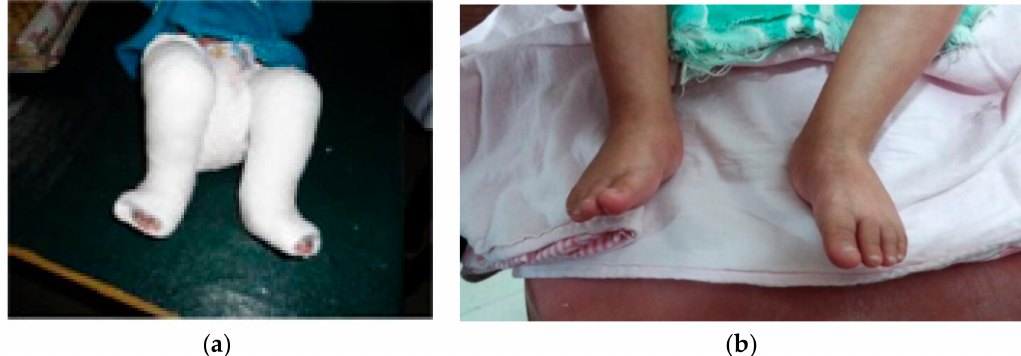
Figure 6. ( a ) Last cast (fifth cast) for equinus; ( b ) after removal of fifth